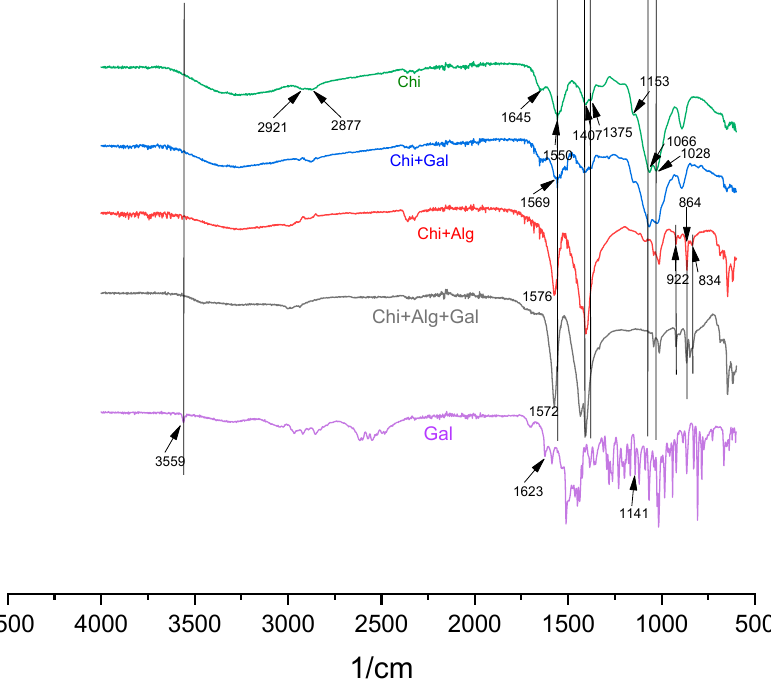
Figure 3. ATR-IR spectra of chitosan, chitosan/alginate complexes, GH-loaded chitosan particles, GH-loaded chitosan/alginate particles, and pure GH.